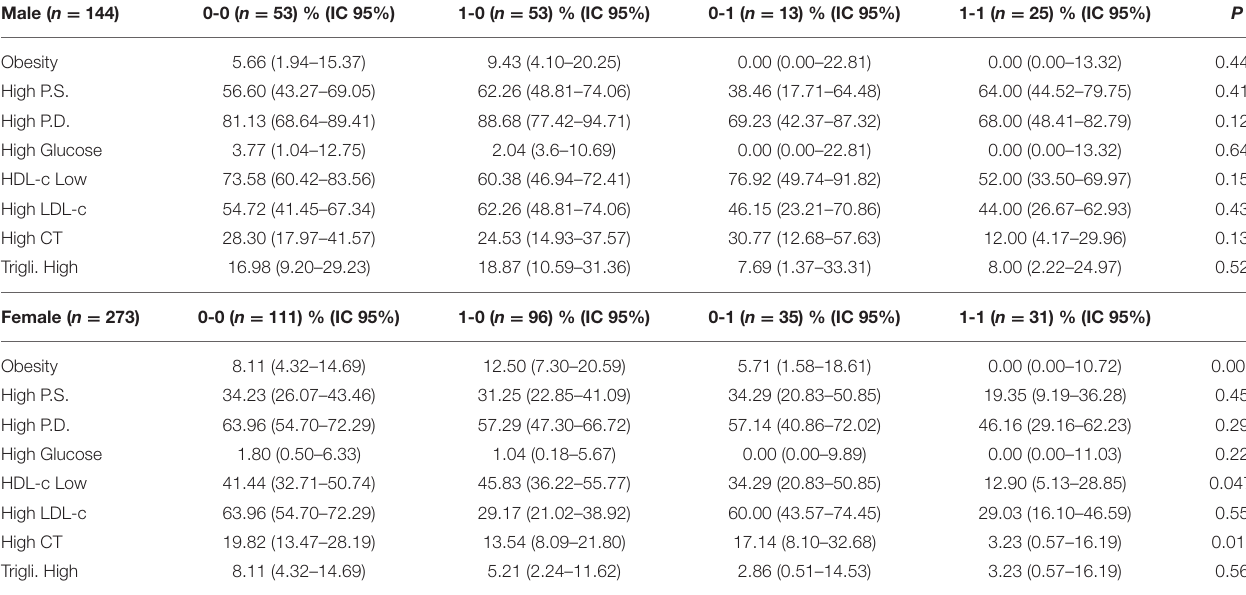
TABLE 2 | Trajectories of cardiovascular risk factors according to participation in sports activities in youth and current physical activity (%, 95% IC), separated according to sex.